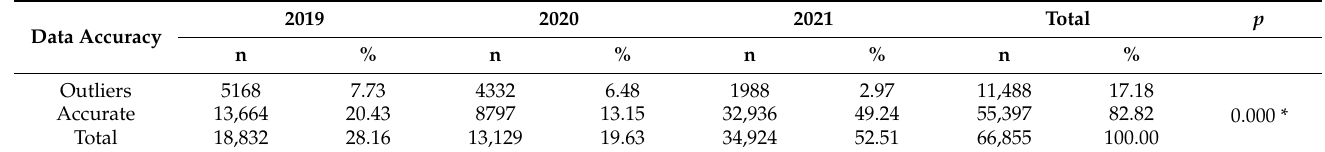
Table 2. Total data accuracy analysis each